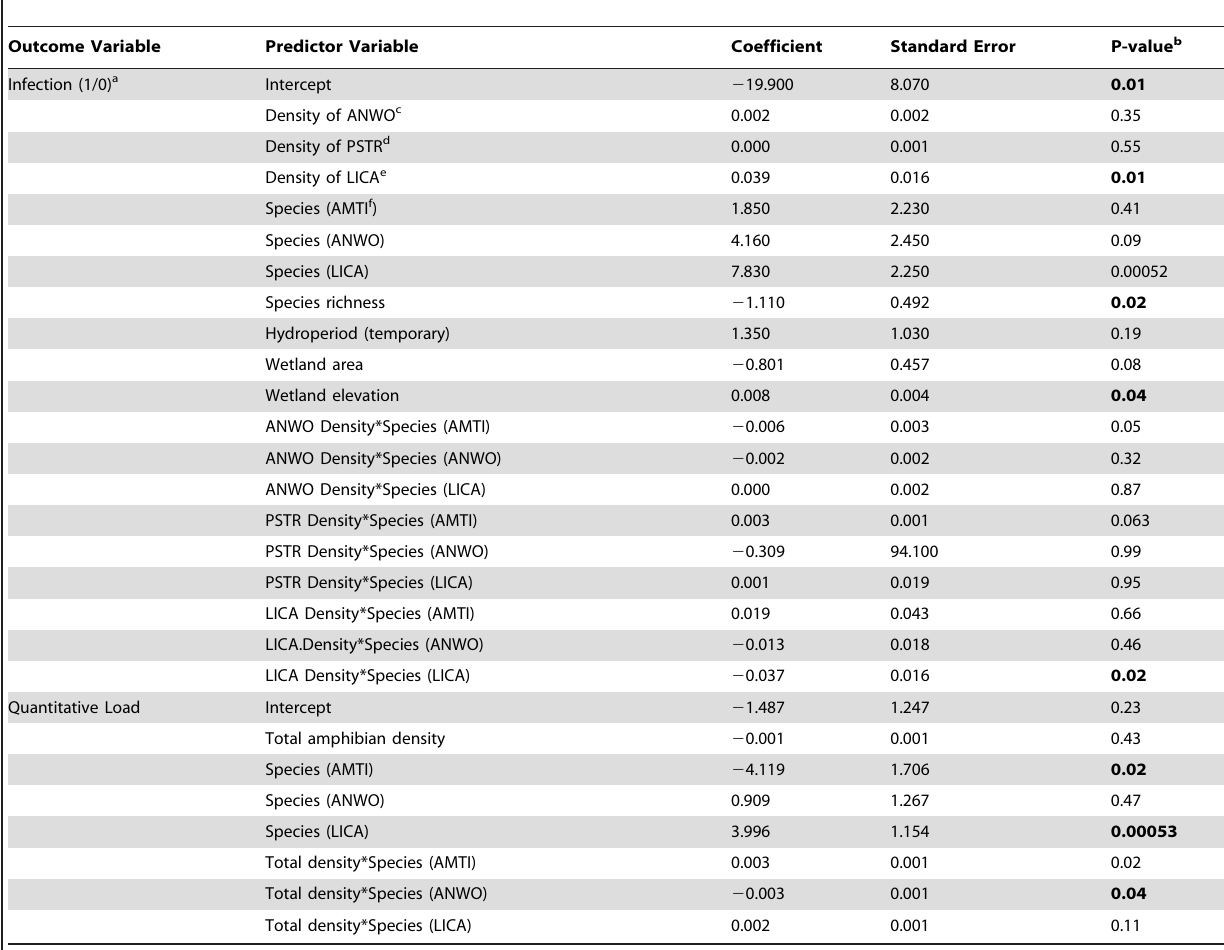
Table 1. Results from best-supported GLMM models predicting 1/0 Bd infection in individuals and quantitative Bd infection